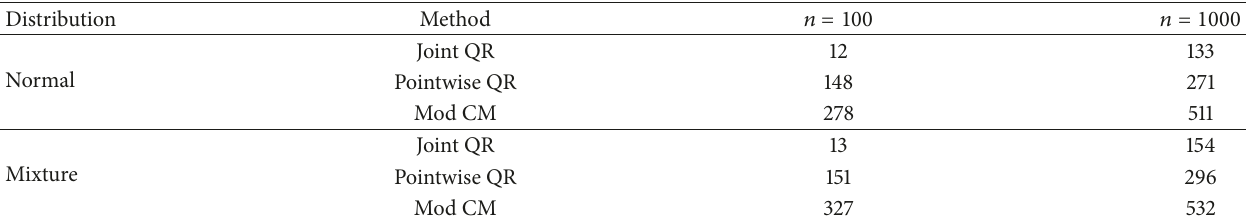
Table 4: Average computing time (in seconds) of the three approaches that involve estimating the conditional distribution for the case of having a scalar covariate and a densely observed functional